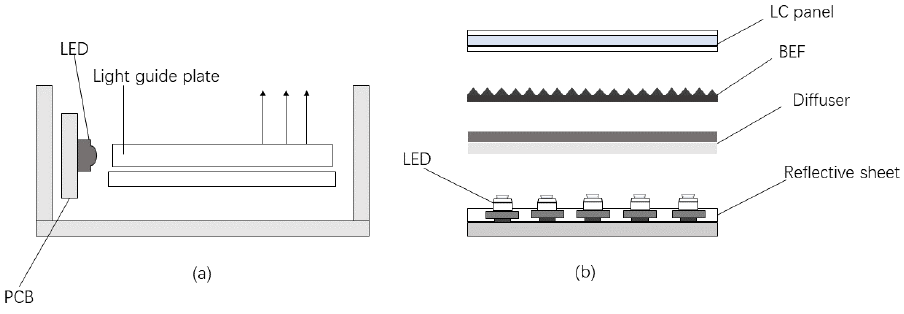
Figure 3. Schematic diagram of LCD backlight unit: ( a ) Edge-lit backlight; ( b ) Direct-lit backlight. Despite the differences in the structure, the modulation process of the light after being emitted from BLU is identical. Using a picture of the candle as an example, Tan et al. briefly describes the modulation process of the light after being emitted from the BLU [25]. Taking direct-lit backlight as an example, Mini-LEDs in each dimming zone were first set to different gray levels according to the image content, as in Figure 4A. Then, the light was evenly diffused to the LC panel after passing through the diffuser, forming a preliminary simulated brightness distribution, as in Figure 4B. Finally, each pixel was modulated through the LC panel R/G/B channel to achieve a full-color image display, as in Figure 4C.